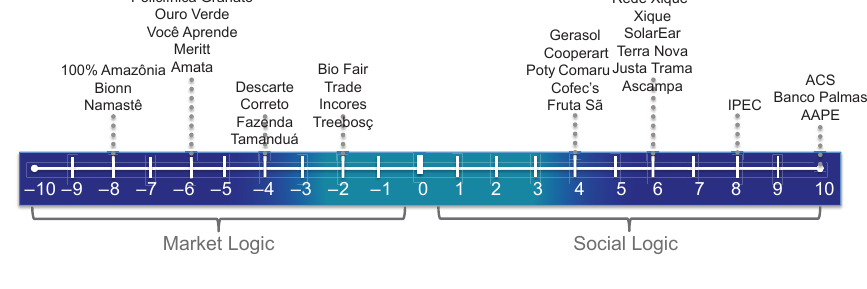
Figure 3. Social ventures analyzed